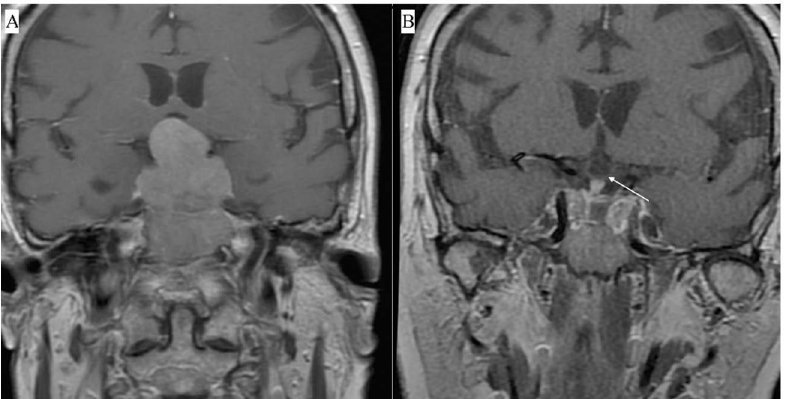
Figure 1. Contrast-enhanced MRI showing a macroadenoma penetrating into the suprasellar region and compressing the optic chiasm. Preoperative T1—weighted contrast-enhanced coronal view ( A ), postoperative T1—weighted contrast-enhanced coronal view. The white arrow indicates the optic chiasm visible after tumor resection ( B ).